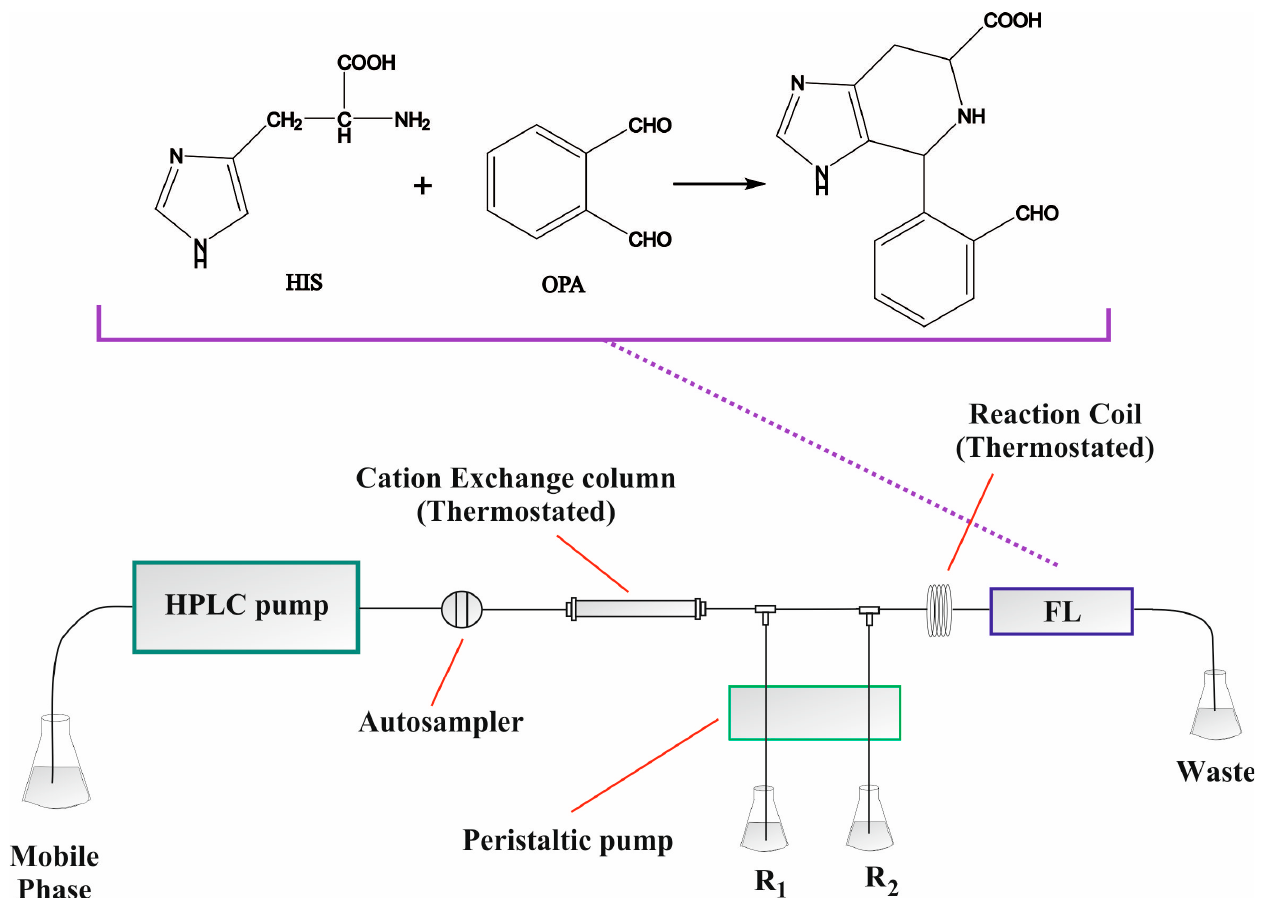
Figure 1. Graphical depiction of the HPLC-PCD setup for the determination of free histidine in hair care products; 5 mmol L − 1 HNO 3 mobile phase at 1 mL min − 1 (60 °C), 10 mmol L − 1 OPA, 50 mmol L − 1 KH 2 PO 4 (pH = 9), 0.25 mL min − 1 flow rate for each stream, 200 cm reaction coil (60 °C), λ ex / λ em = 340/460 nm.